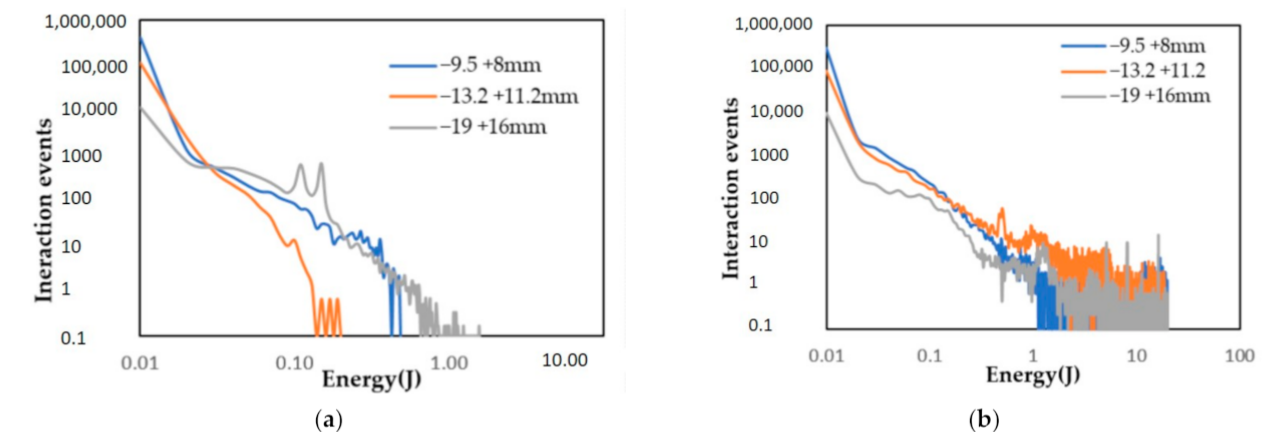
Figure 4. Energy spectra for the effect particle size on ( a ) single rotor and ( b ) double rotor design for 1040 rpm rotor speed.